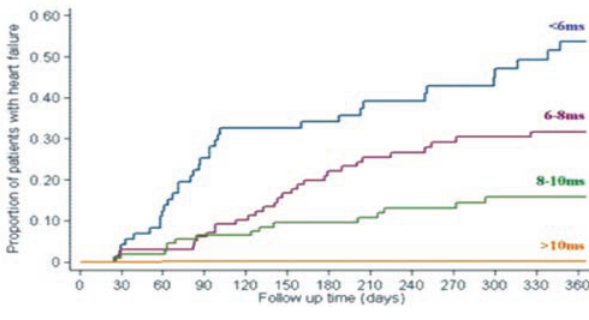
Figure 6. Lower heart T2* values are associated with increased risk for heart failure (Kirk et al. , 2009).